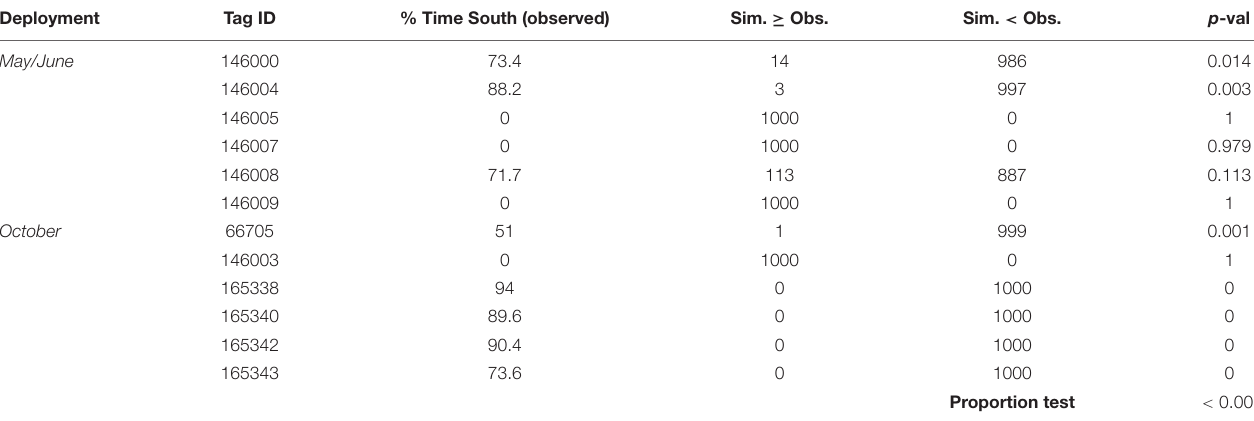
FIGURE 5 | Core area use for all tag observations (left) and tag simulations (right) represented by the estimates. TABLE 2 | Time spent south of the Ningaloo WHA for tagged M. alfredi (observed) compared to simulated tracks, including the number of tracks that spent more or less time than observed and the associated p- value. Deployment Tag ID % Time South (observed) Sim. ≥ Obs. Sim. < Obs. p -val